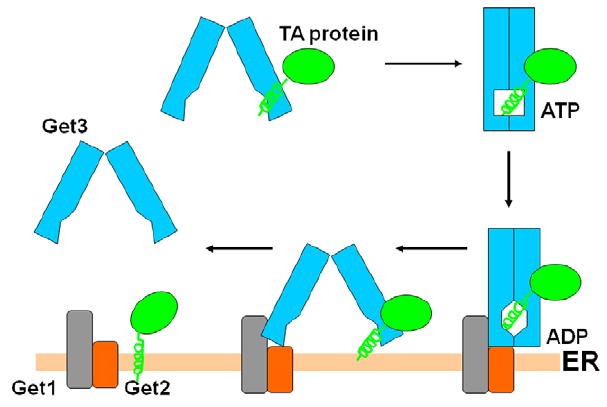
Figure 6. The working model for Get3 to facilitate the TA protein biogenesis. The TMD of the TA protein is shown in a green helix. Get1, Get2 and Get3 are labeled. The ATP-bound state and ADP- bound state of Get3 are labeled.